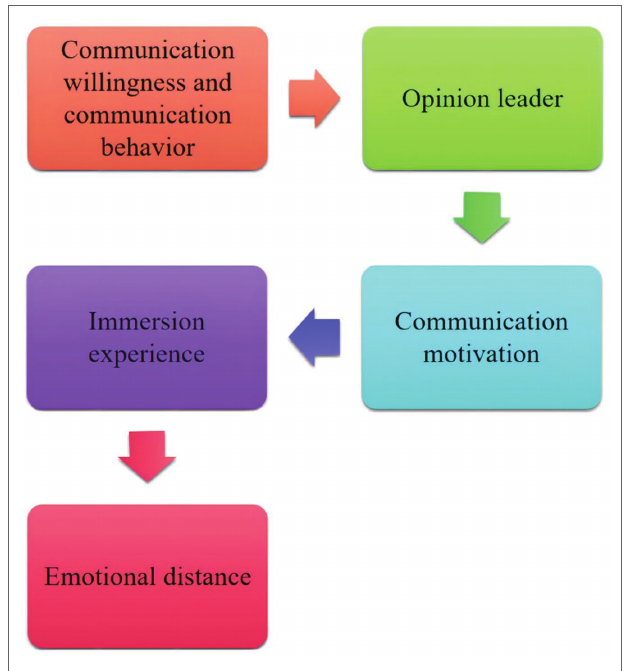
FIGURE 4 | This paper puts forward the flow chart of the hypothesis